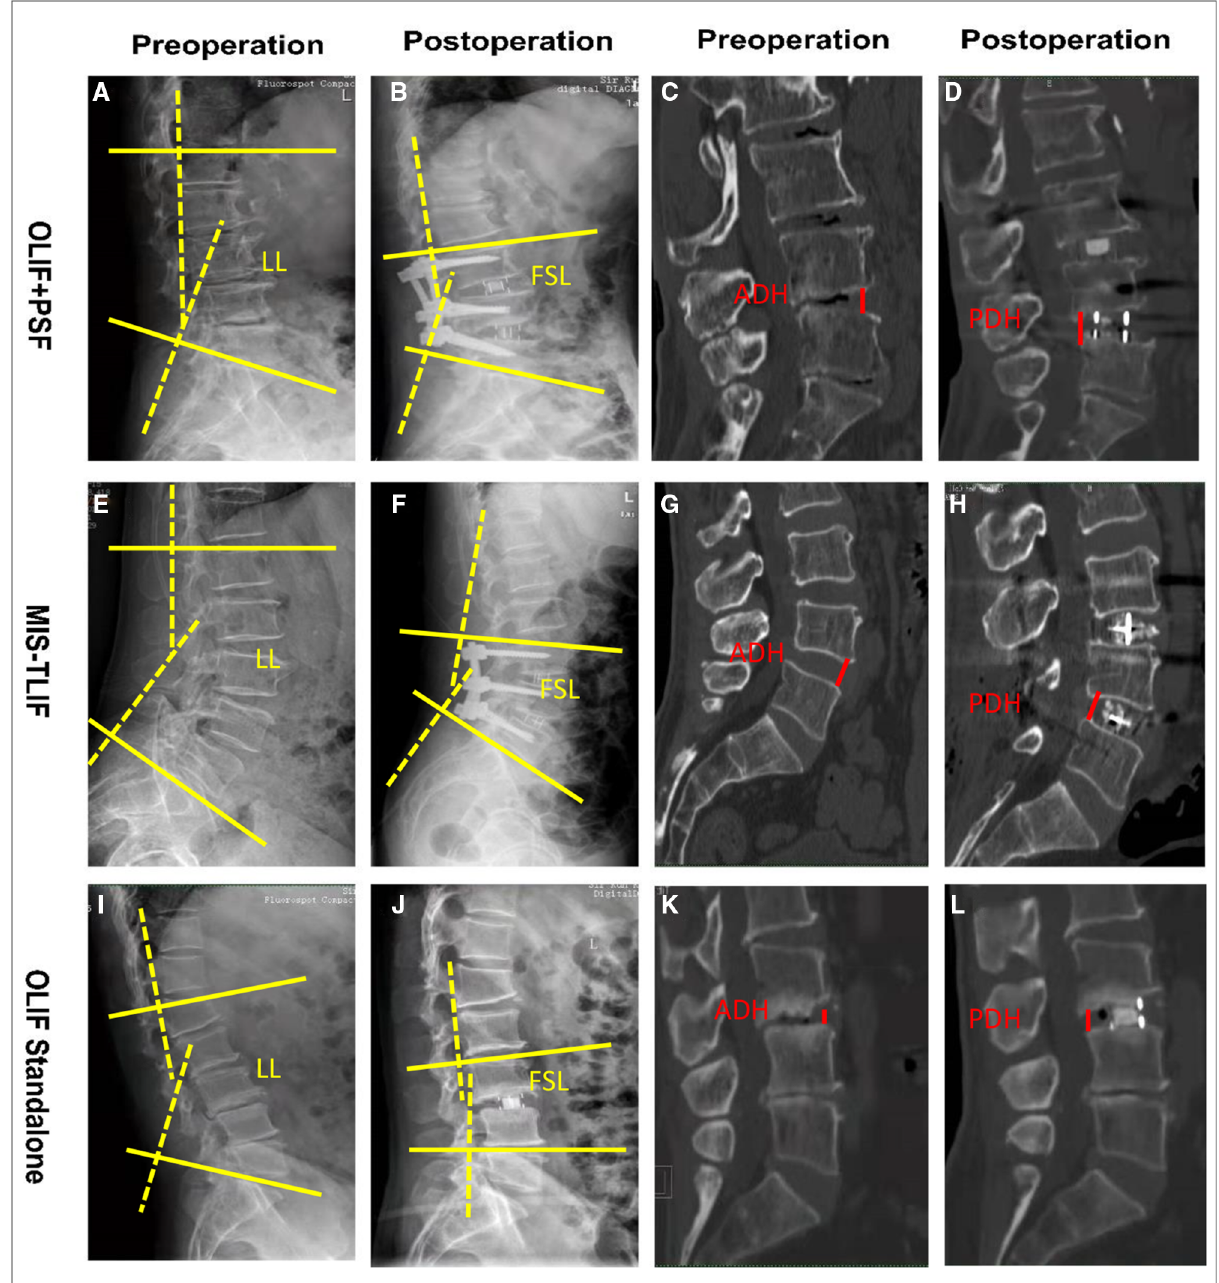
FIGURE 4 Schematic diagram of pre- and post-operative imaging parameter measurements. OLIF+PSF group: ( A,B ). Pre- and post-operative LL and FSL. ( C,D ) Pre- and post-operative ADH and PDH. MIS-TLIF group: ( E,F ) Pre- and post-operative LL and FSL of. ( G,H ) Pre- and post-operative ADH and PDH. OLIF Standalone group: ( I,J ) Pre- and post-operative LL and FSL. ( K,L ) Pre- and post-operative ADH and